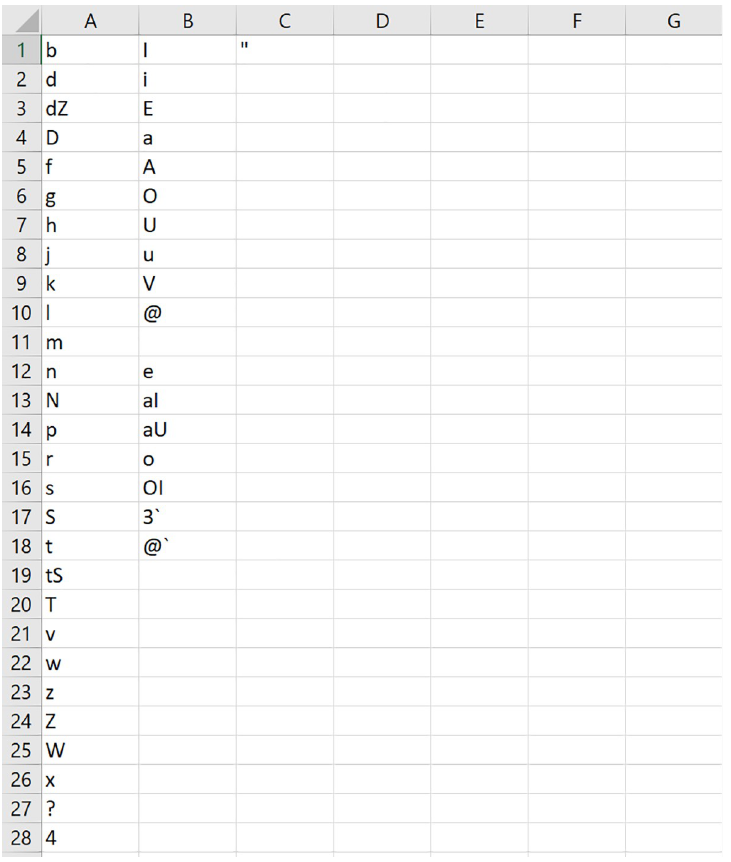
Fig 4. Example of a CSV UTF-8 (comma delimited) phonetic system file. Consonants are listed in the first column, and vowels are listed in the second column. The application will recognize diphthongs (combinations of two vowels) if they are listed as a single entity. The stress marking for primary stress is listed in the third